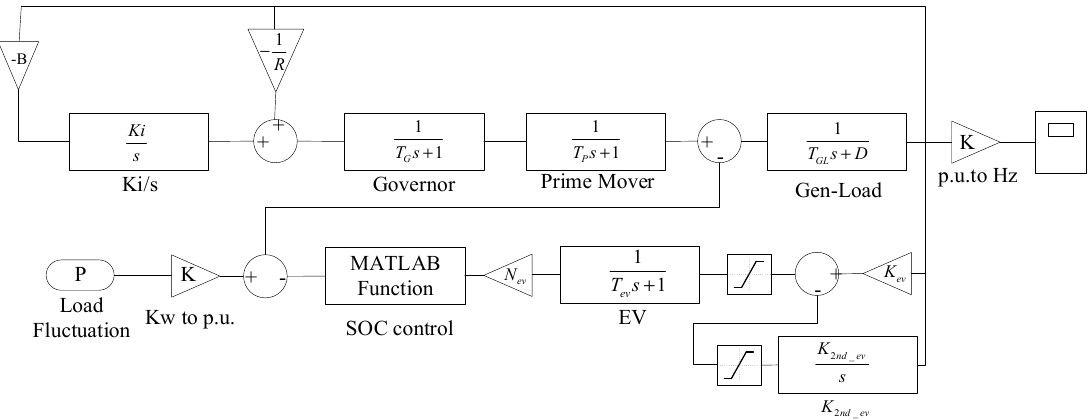
Figure A1. Regulation control model of proposed algorithm.